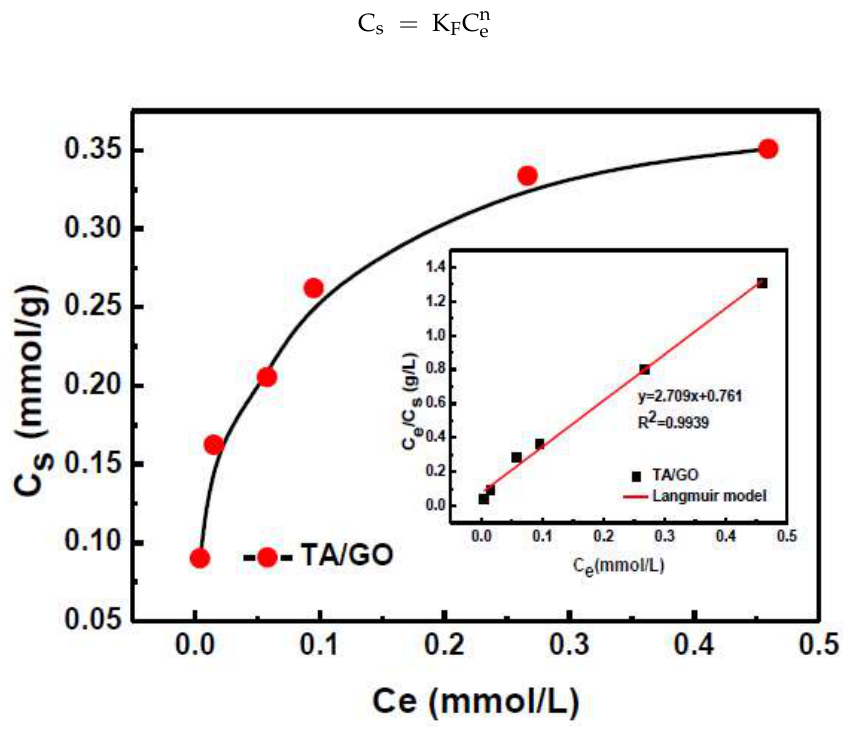
Figure 7. Sorption isotherms of U(VI) ions on TA / GO at pH = 3.6 ± 0.03, T = 298 K, m / V = 0.6 g / L, I = 0.001 M NaCl. Table 3. Parameters of the Langmuir and Freundlich models for U(VI) ion sorption on TA/GO composites.